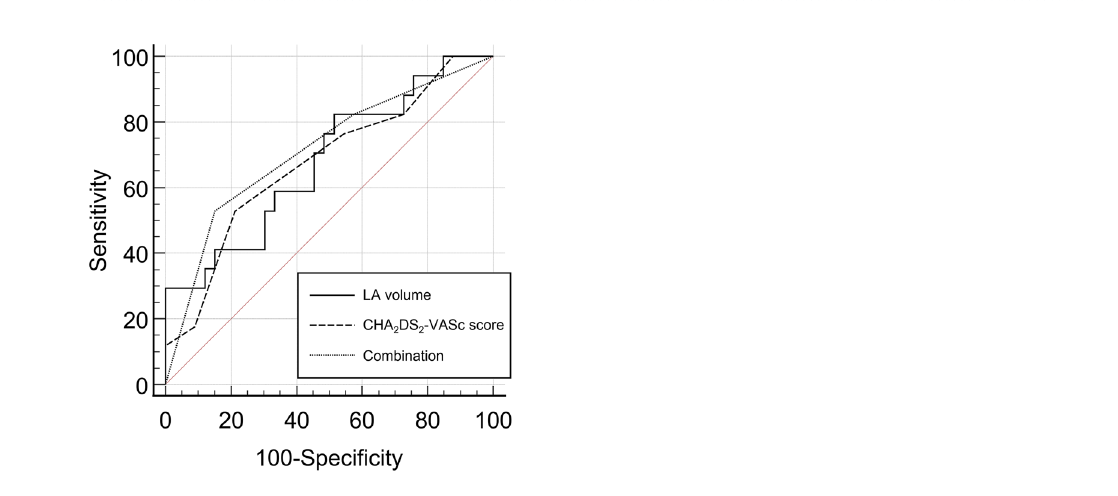
Figure 2. Receiver–operating characteristic (ROC) curve analysis for predicting pulmonary vein stump thrombus after left upper lobectomy. The area under the ROC curve values were 0.679, 0.676, and 0.714 for left atrial volume, CHA 2 DS 2 -VASc score, and the combination of the two parameters,